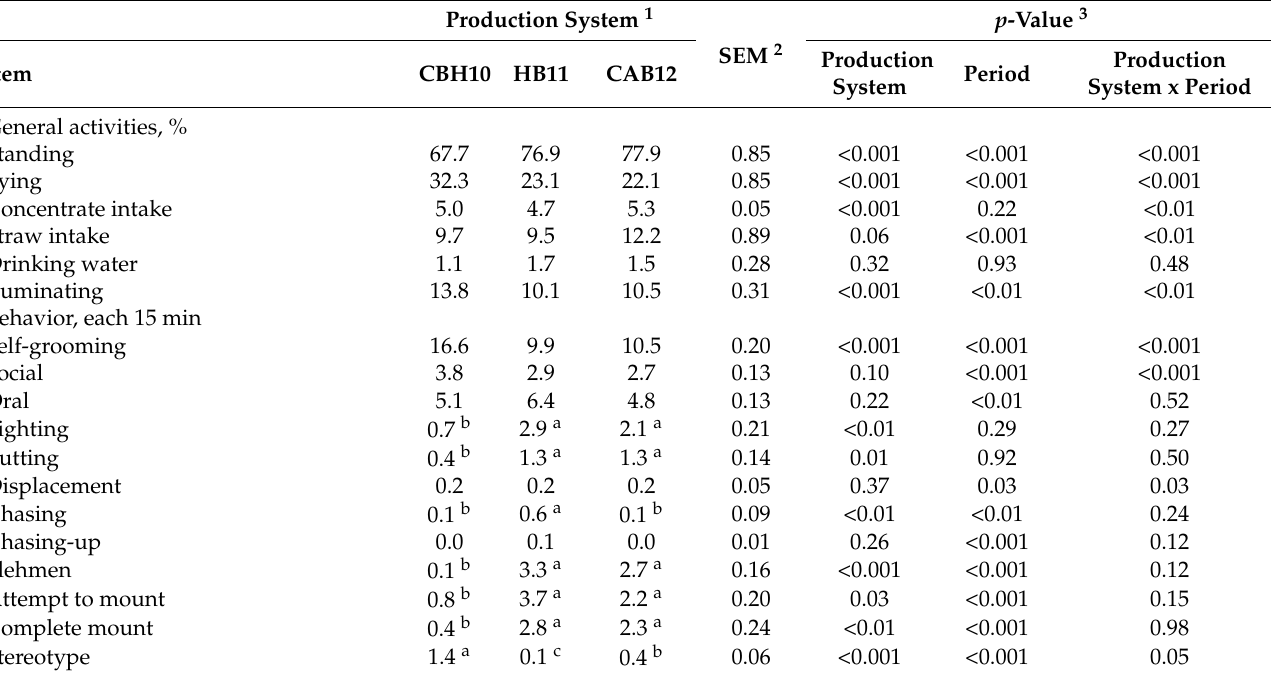
Table 3. Animal behavior for the first 168 days in different Mediterranean beef fattening systems.